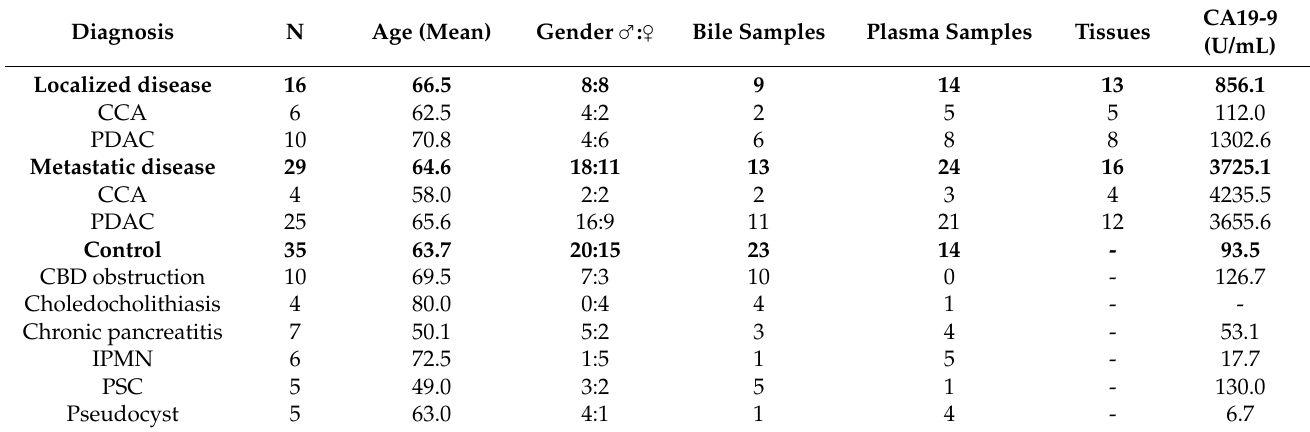
Table 1. Overview of patient collective.